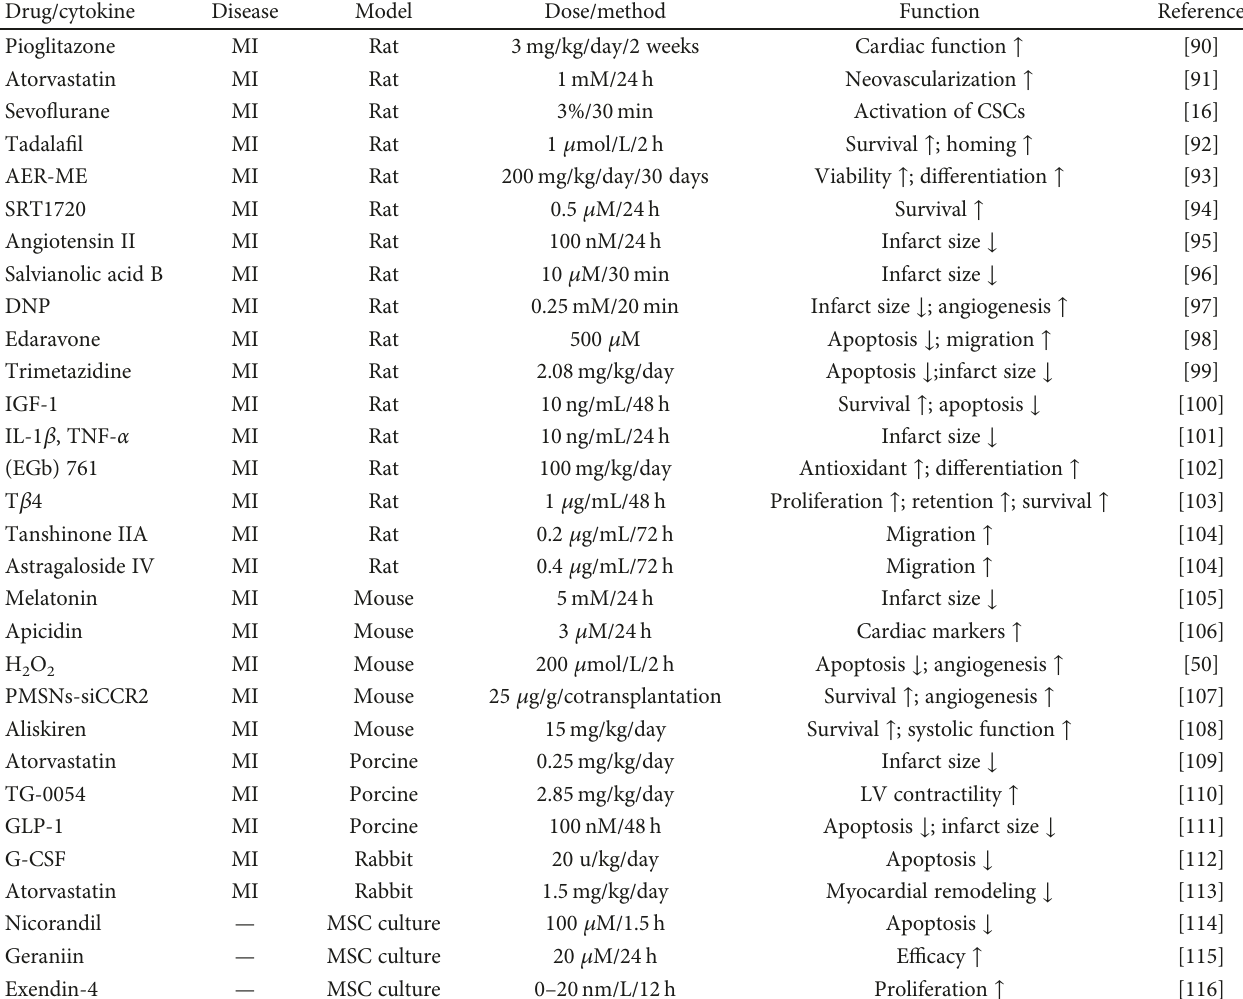
Table 3: Drug/cytokine pretreatment in MSC transplantation for treating